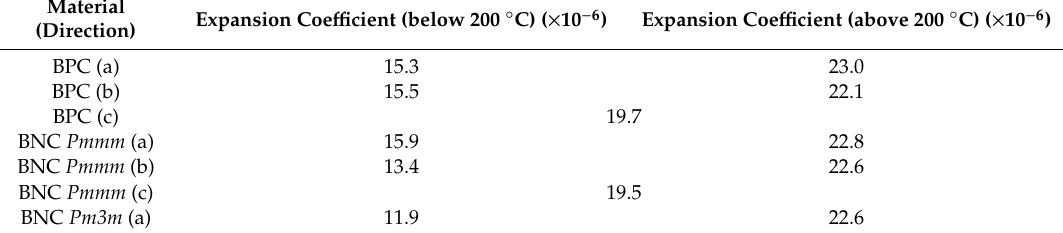
Table 1. Thermal expansion coe ffi cients.